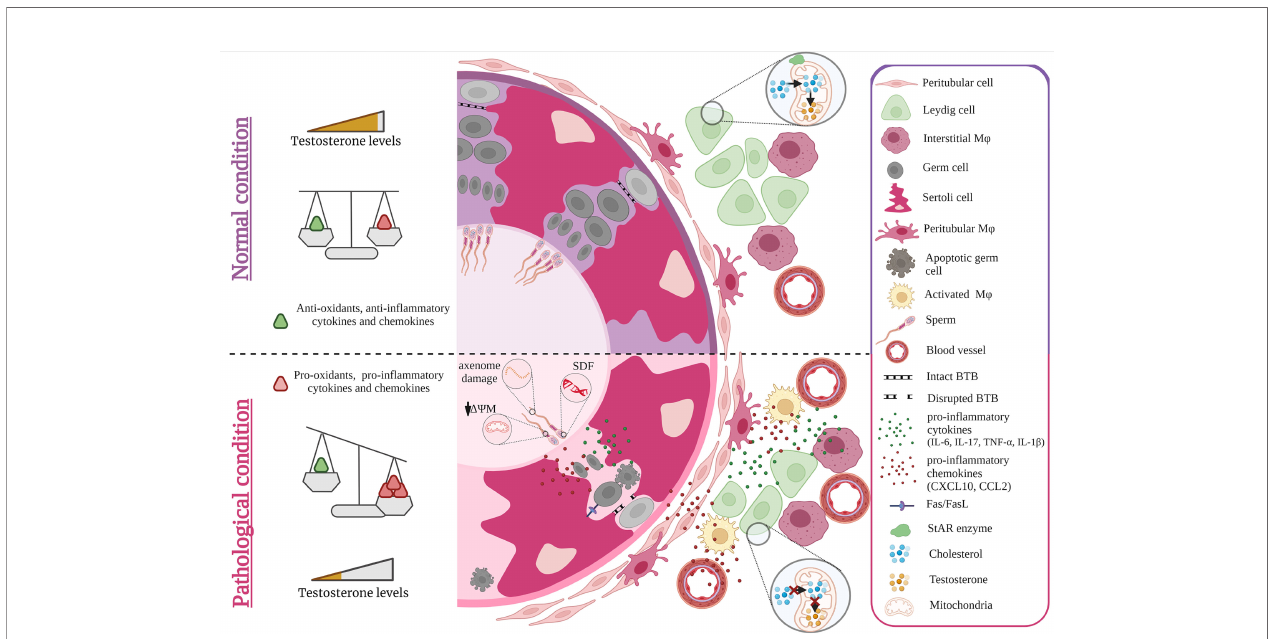
FIGURE 1 | Effect of cytokines and oxidative stress on spermatogenesis and steroidogenesis. Under normal conditions, levels of anti- and pro-in fl ammatory cytokines, chemokines as well as anti-and pro-oxidants are balanced maintaining steroidogenesis and spermatogenesis. Sterile in fl ammation and microbial infection both cause an invasion of monocyte derived macrophages that together with increased production of pro-in fl ammatory cytokines such as IL-6, TNF- a , IL-17, IL-1 b and chemokines such as CCL2, CXCL10 by resident testicular cells as well as recruited immune cells result in a shift towards higher levels of pro-in fl ammatory factors that negatively impact spermatogenesis and steroidogenesis. As a consequence, germ cell death and lower levels of androgens are observed e.g. by ROS diminishing the expression of StAR. ROS induced damage of spermatozoa also occurs during epididymal transit (axoneme damage, decreased mitochondrial potential = DY M, sperm DNA fragmentation =SDF). Figure created with